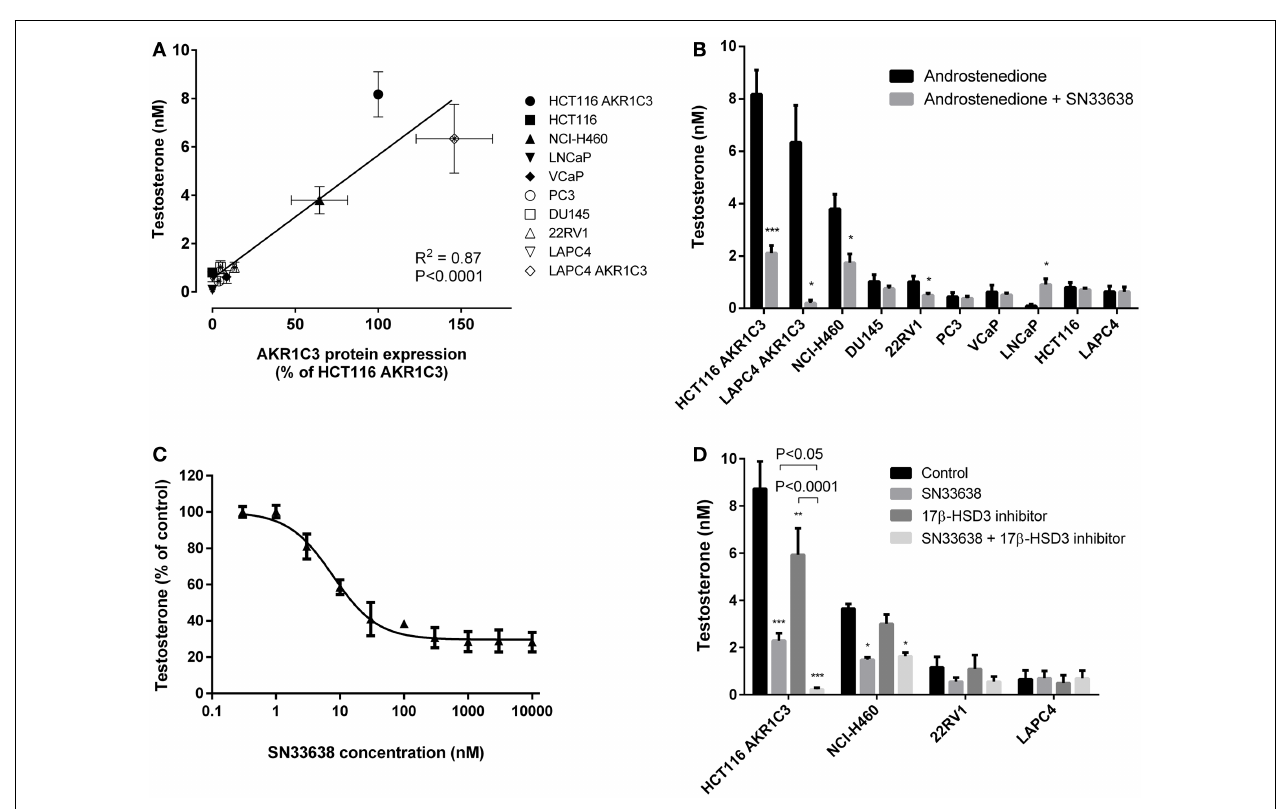
( n = 3). (D) Testosterone levels in HCT116 AKR1C3, NCI-H460, 22RV1, and LAPC4 cell lines following treatment with 10 µ M SN33638 and 1 µ M 17 β -HSD3 inhibitor alone or in combination ( n = 3–6). Bars or symbols represent the mean ± SEM. Statistical significance of correlation analysis was evaluated by Spearman’s rank-order correlation and of differences between mean values by Student’s t -test (B) or two-way ANOVA withTukey’s multiple comparison analysis (D) .* P < 0.05; ** P < 0.01; *** P < 0.001 vs. no inhibitor controls. Statistically significant differences between treatment groups are marked as